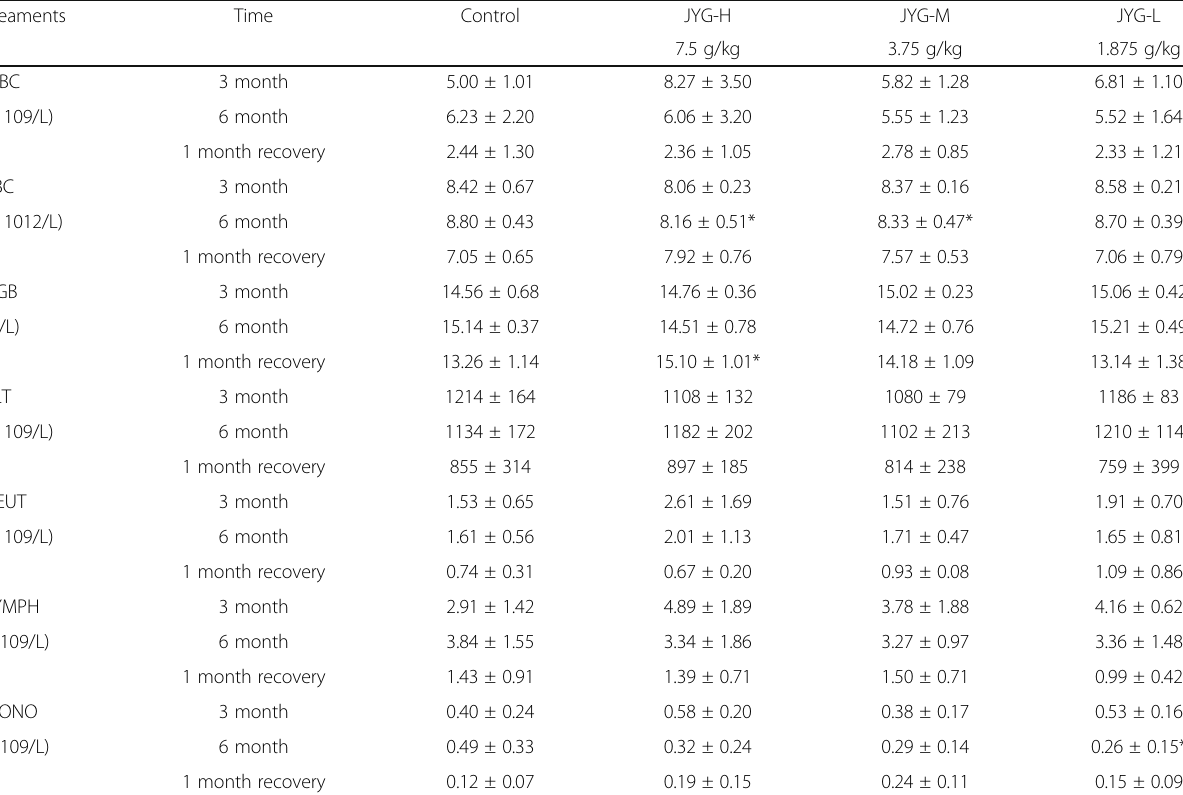
Table 4 Hematological parameters of male rats in chronic toxicity test